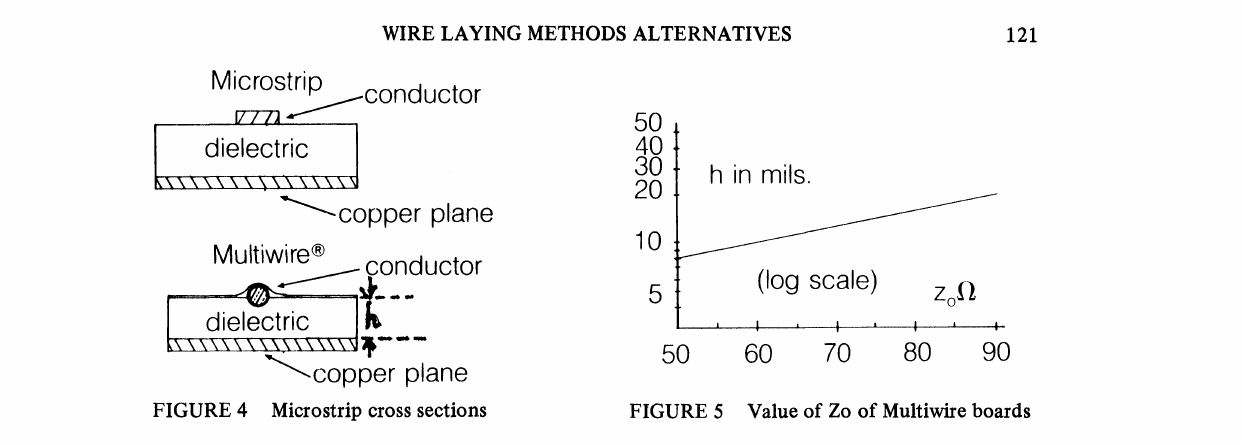
FIGURE 4 Microstrip cross sections FIGURE 5 Value of Zo of Multiwire